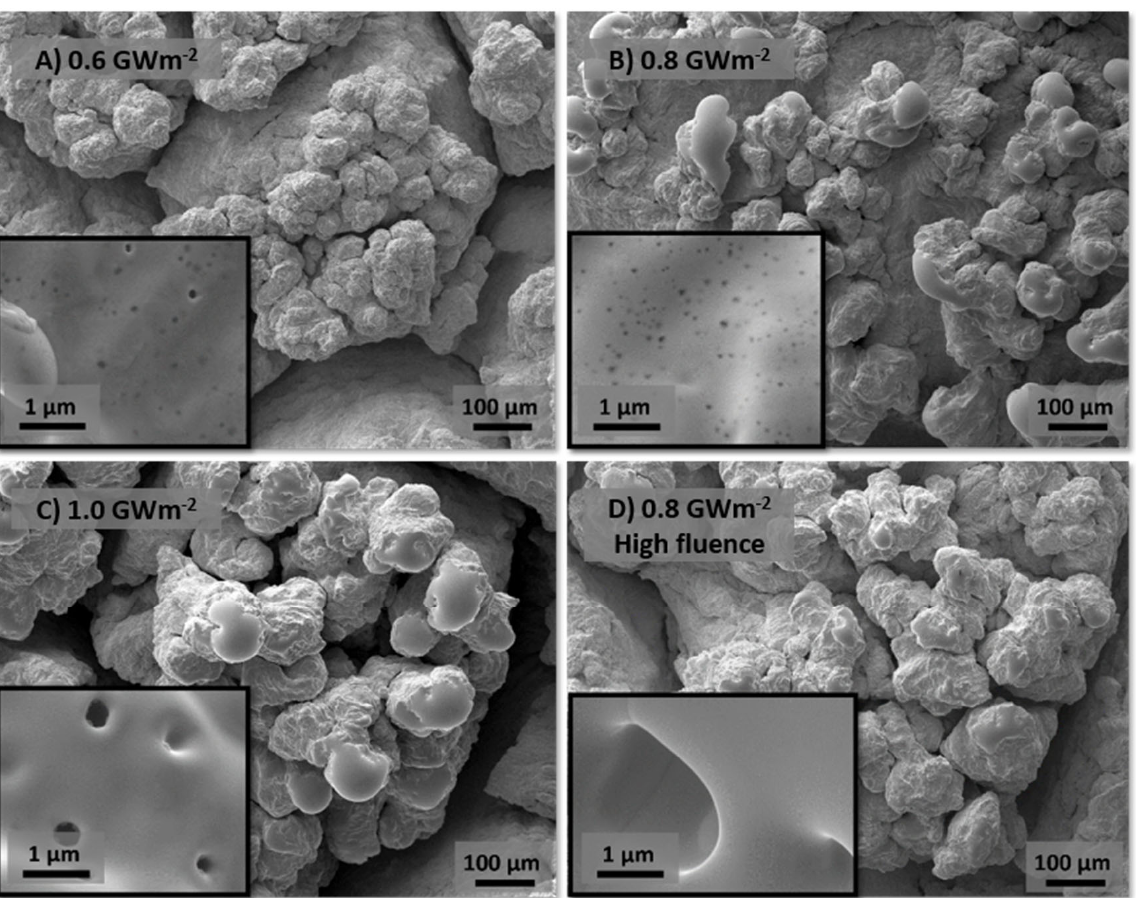
Figure 2. Close-up of the laser-affected area of all samples exposed to D/He (6%) plasma. Samples were simultaneously exposed to 10 5 laser pulses with a P abs of ( A ) 0.6 GWm − 2 , ( B ) 0.8 GWm − 2 , ( C ) 1.0 GWm − 2 and ( D ) 0.8 GWm − 2 . Sample D was exposed to a higher plasma fluence than samples A, B and C.